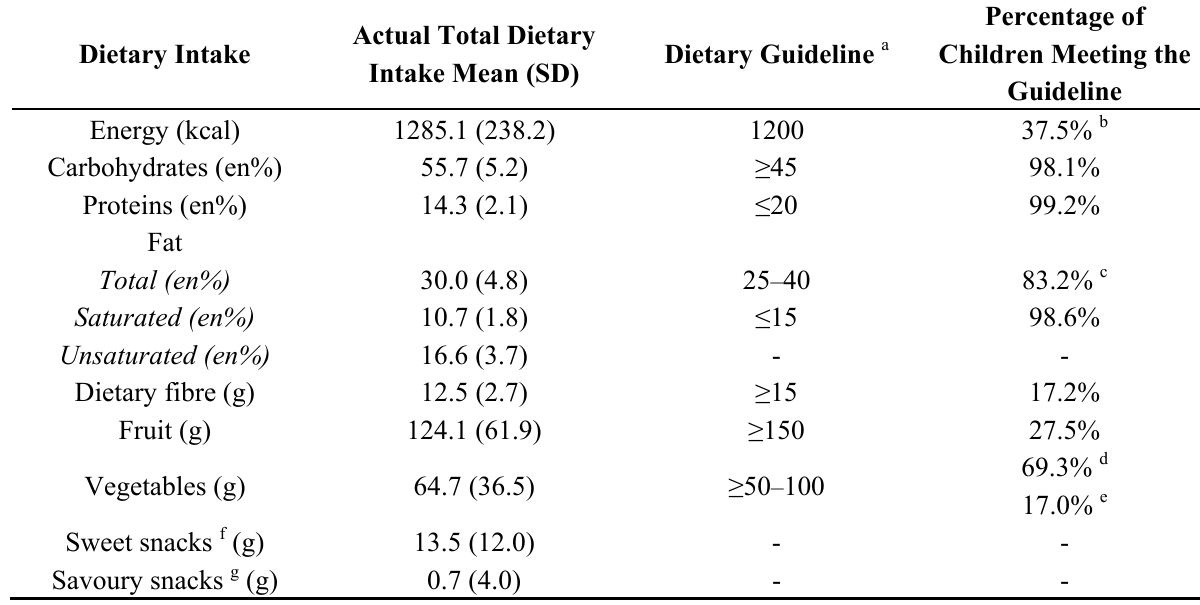
Table 1. Total dietary intake by toddlers, compared to national guidelines ( N =